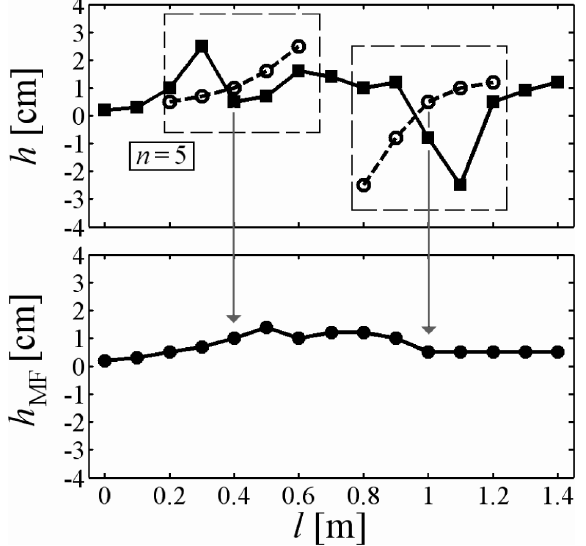
Fig. 1. Principle of a median fi